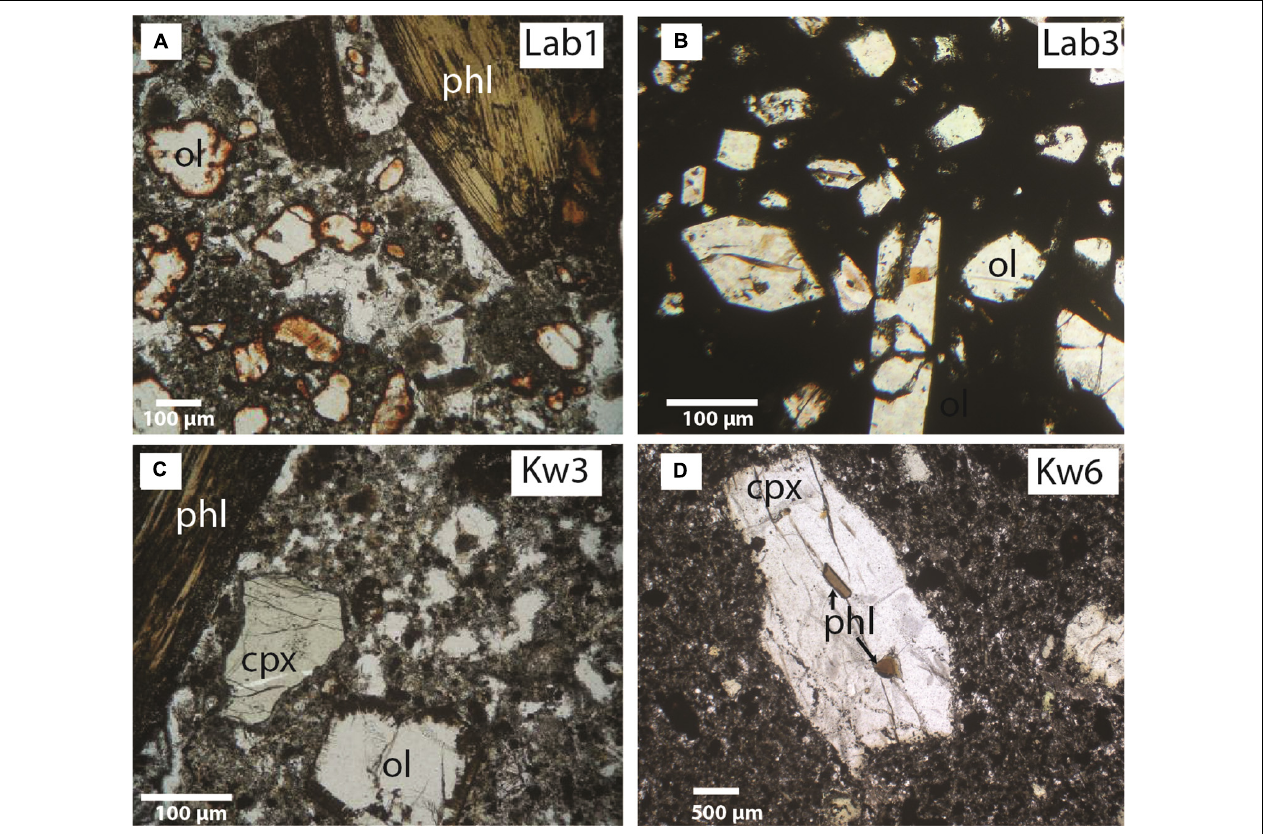
FIGURE 2 | Representative microphotographs of sampled lavas: nephelinites from (A,B) Labait (Lab1, Lab3), (C,D) Kwaraha (Kw3, Kw6) Abbreviations: ol, olivine; phl, phlogopite; clinopyroxene, cpx.